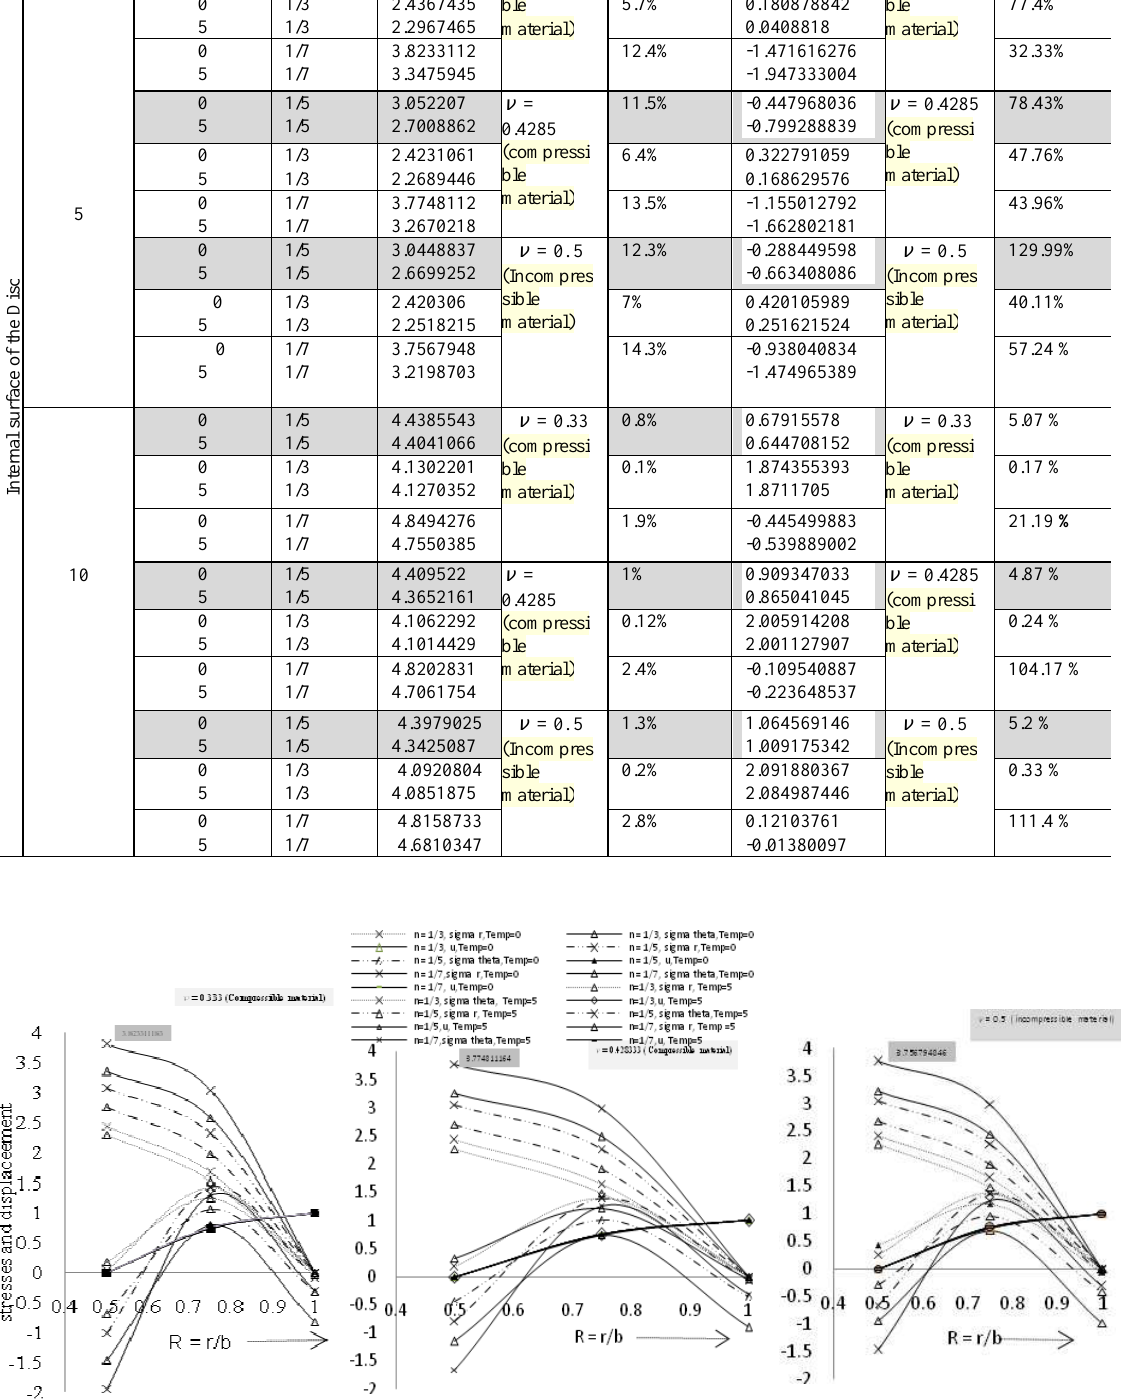
Figure 5(a). Stresses and displacement distribution along the r adii ratio R = r/b at angular speed 2 5 W =